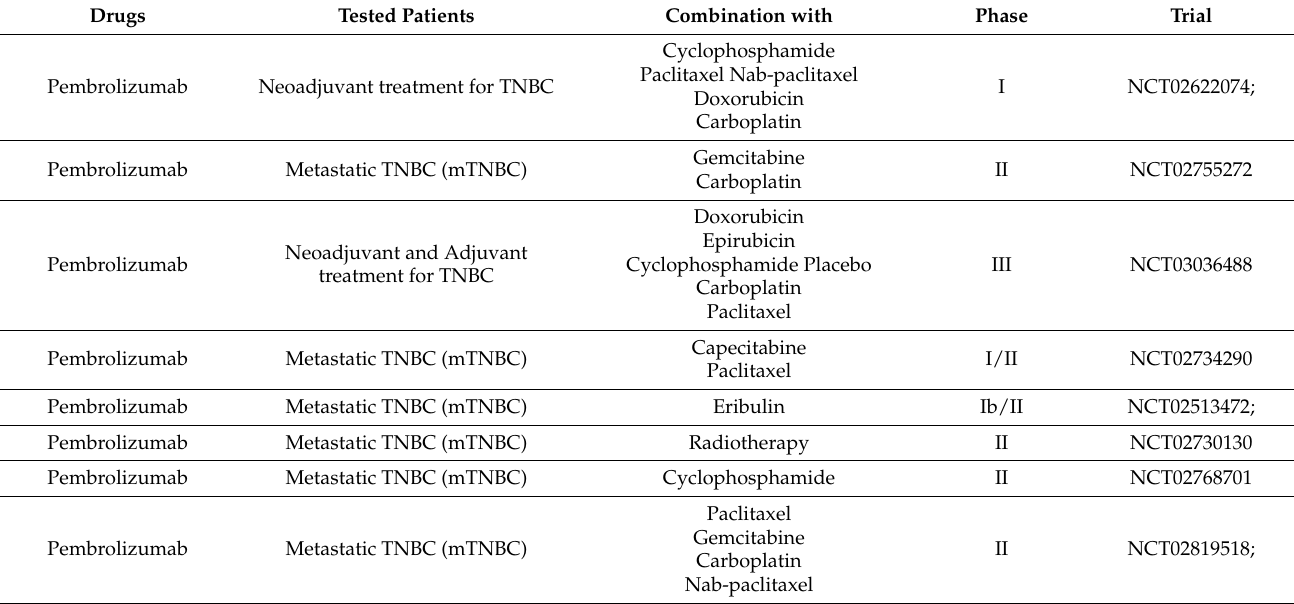
Table 4. Clinical trials of PD-L1 combination therapy with conventional cytotoxic chemotherapeutics targeting TNBC patients. Drugs Tested Patients Combination with